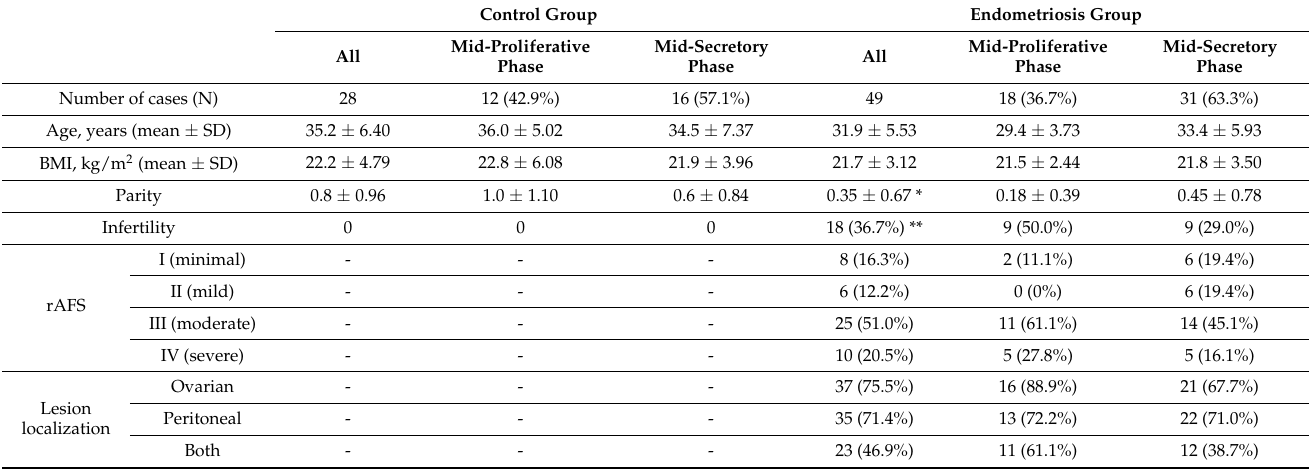
Table 1. Demographic and clinical characteristics of patients with endometriosis and control